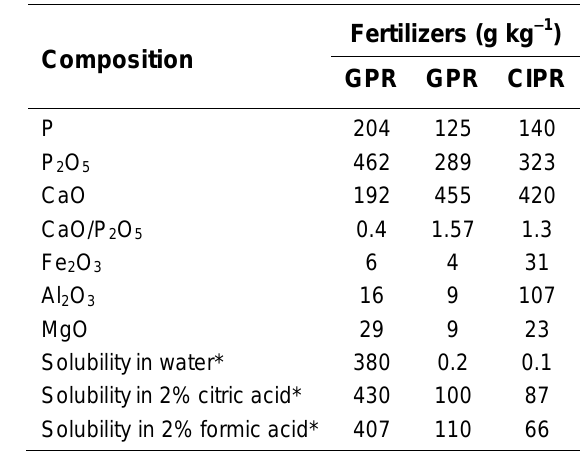
Characteristics of the Fertilizers Used